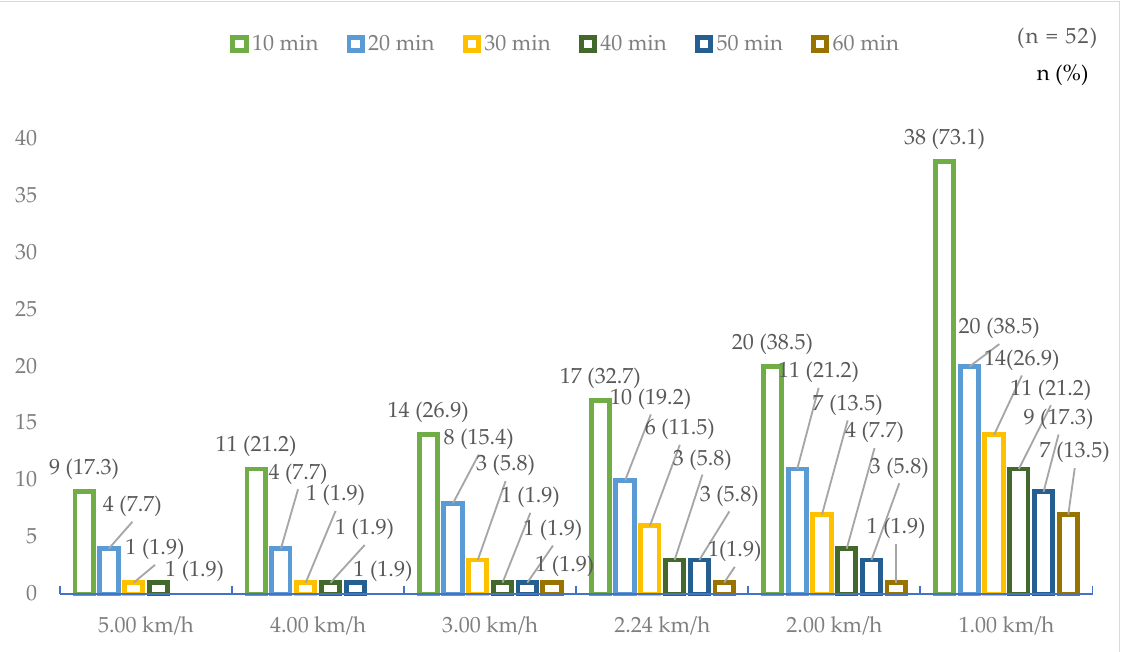
Figure 6. Routes to the nearest vertical evacuation shelter of childcare centers (CCs) ID2, ID3, and ID7, directions of rapid tsunami evacuation, and distances from CCs to the coast. The direction required for rapid tsunami evacuation is indicated by a black arrow with a red border.